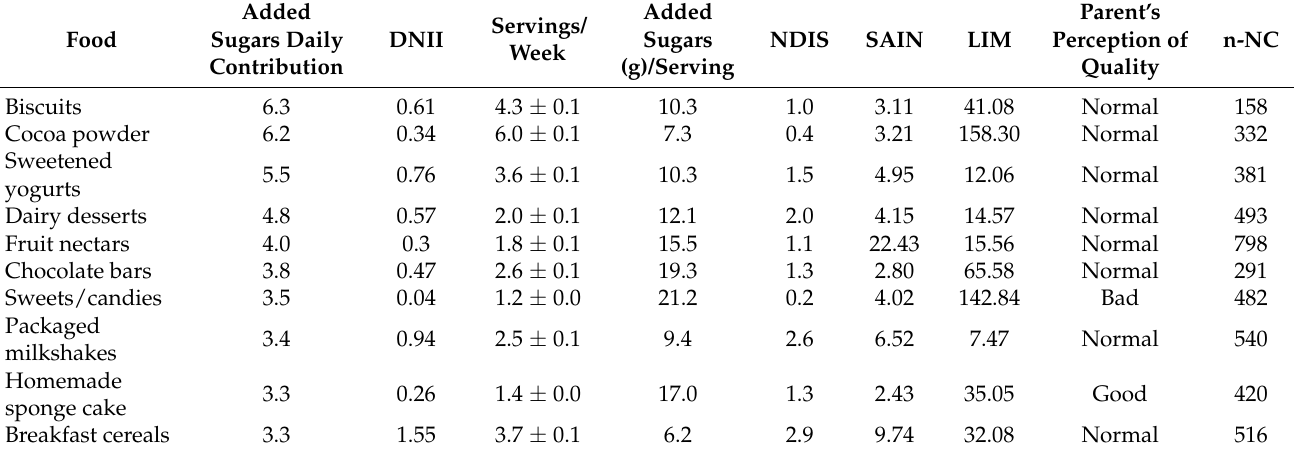
Table 2. Added sugars daily contribution, quality indexes, added sugars, quality perception, and non-consumers of the different products